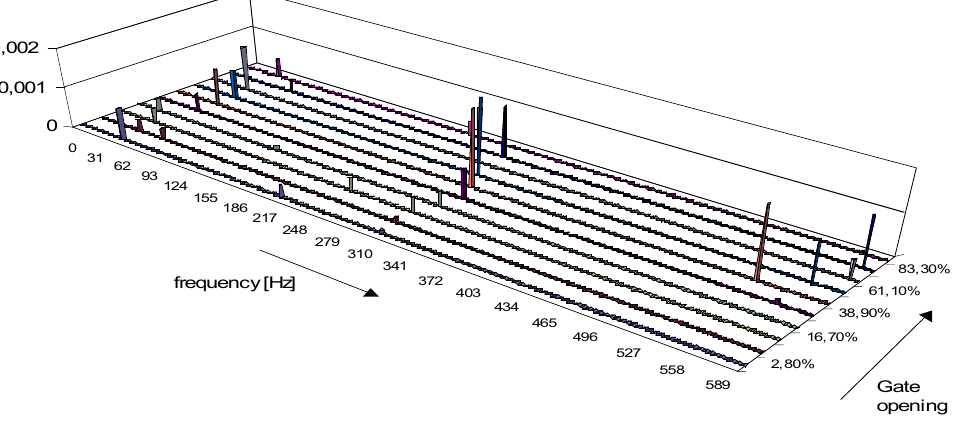
Fig. 7. “Waterfall” power spectra record of acting force at different gate